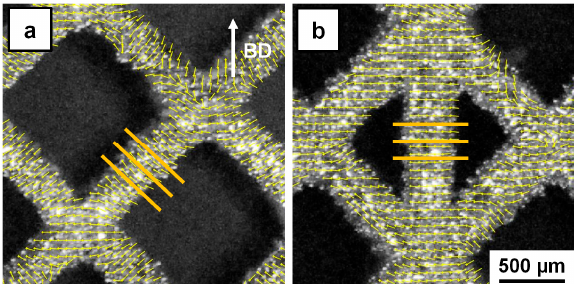
Figure 8. Maximal principal strain vector plots for 316L ( a ) bcc and ( b ) f2ccz lattice structures as obtained by DIC at a macroscopic strain of 1%. The main direction of the vectors is highlighted by the yellow lines in each subimage, the position of the respective sections is highlighted by red squares in Figure 7. The sections of the lattice shown are cropped from the entire structure—recompiled from [35].